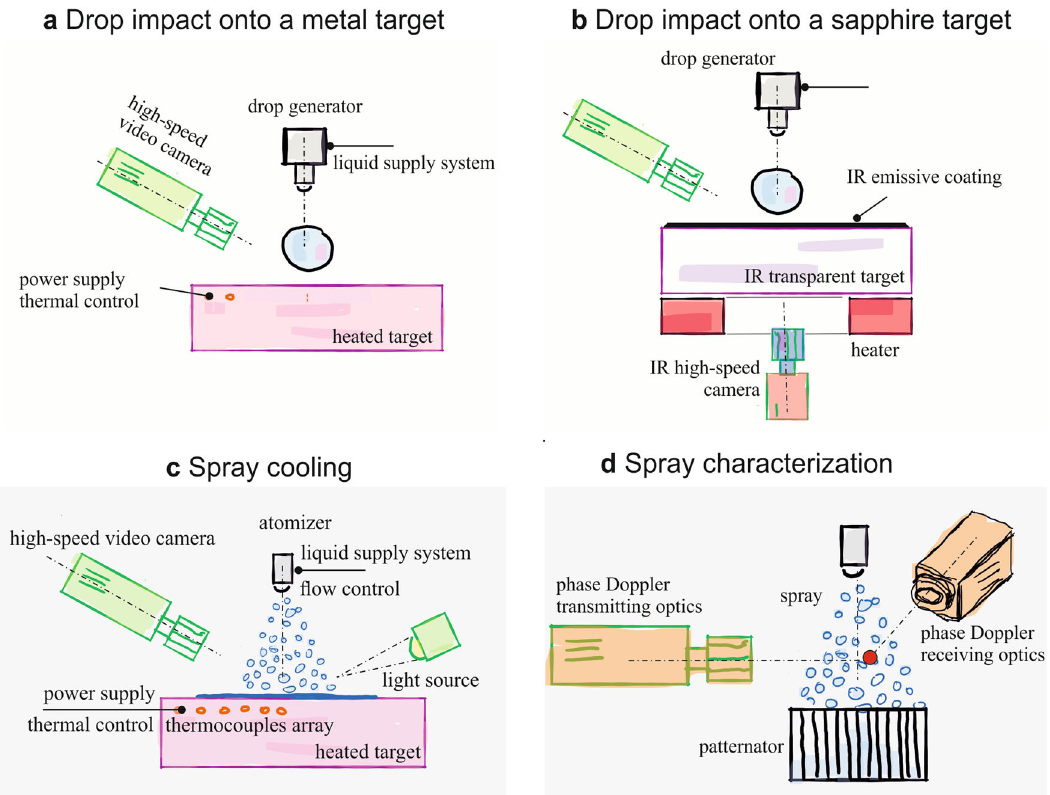
Fig. 6 Sketches of the experimental setups for the single drop and spray cooling experiments. a The setup consists of an adjustable drop generation unit, a heated impact target and a high-speed observation system. The heater and impact target are replaced for IR measurements during the drop impact. b The setup for infrared (IR) measurements. The heater provides bottom view optical access for a high-speed infrared camera. c Setup for characterization of spray cooling . d Setup for detailed spray